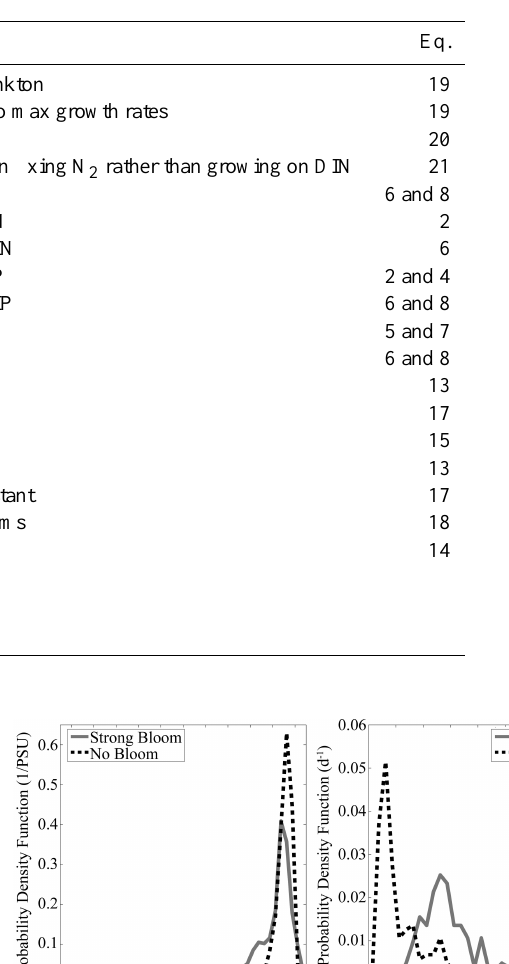
Table 1. Sensitivity Analysis Simulations. All parameters were consecutively halved then doubled for four month simulations run from May–August 1991 and then simulation outputs were compared to comparable outputs from the DIAZO base model run.